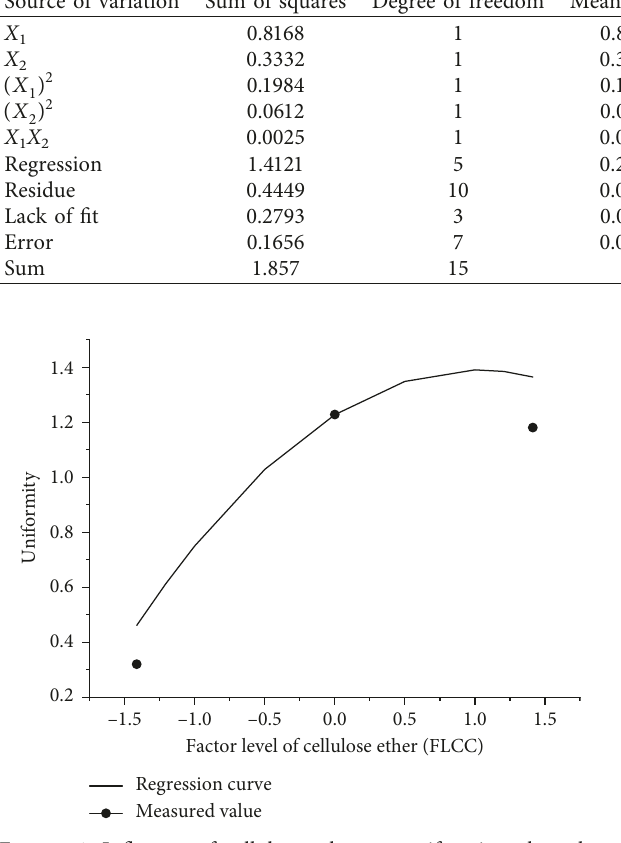
Figure 4: Influence of cellulose ether on uniformity when the substitution rate of rubber is 0.